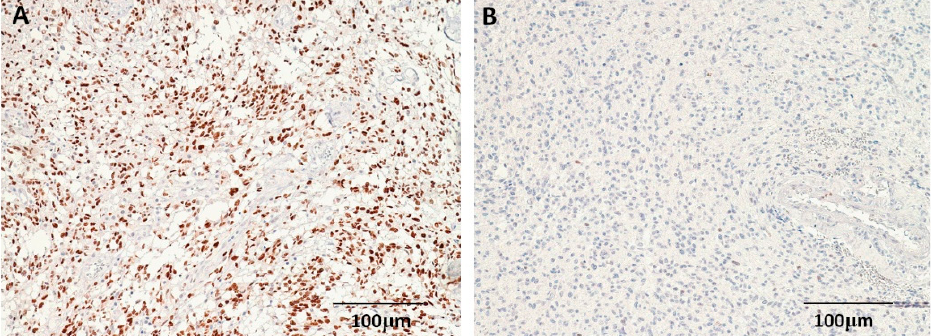
Figure 1. Immunohistochemical staining for p53 in astrocytomas. ( A ) High-level p53 expression in a glioblastoma patient. ( B ) Low-level p53 expression in a patient with grade II glioma (100 × ). Table 1. Correlation of p53/EGFR expression with clinicopathologic parameters in